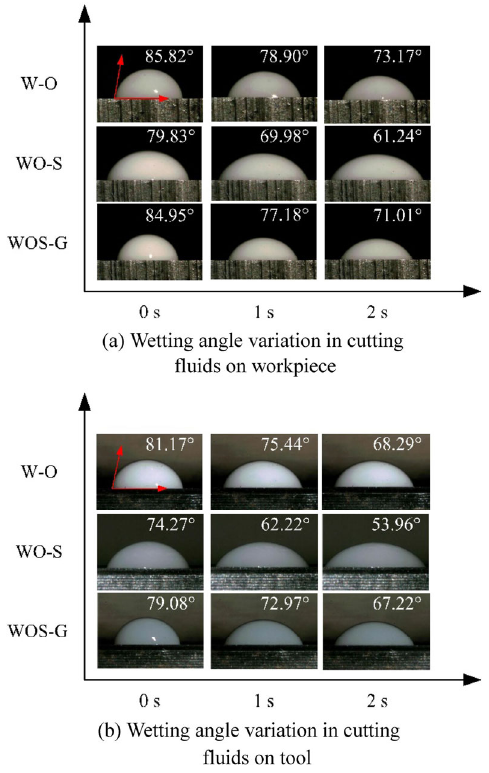
Fig. 10 Wetting angle variation in different types of cutting fluids on different